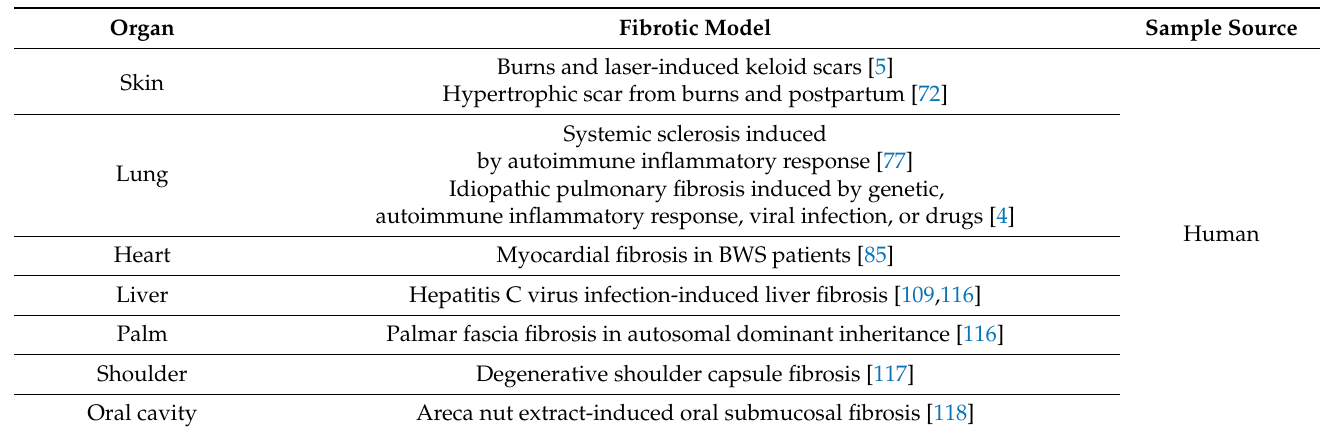
Table 2. Verified IGF-2-overexpressed human organ fibrosis